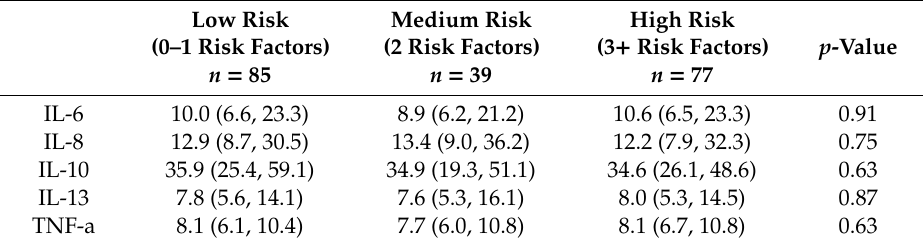
Table 5. Median cytokine levels by risk group.